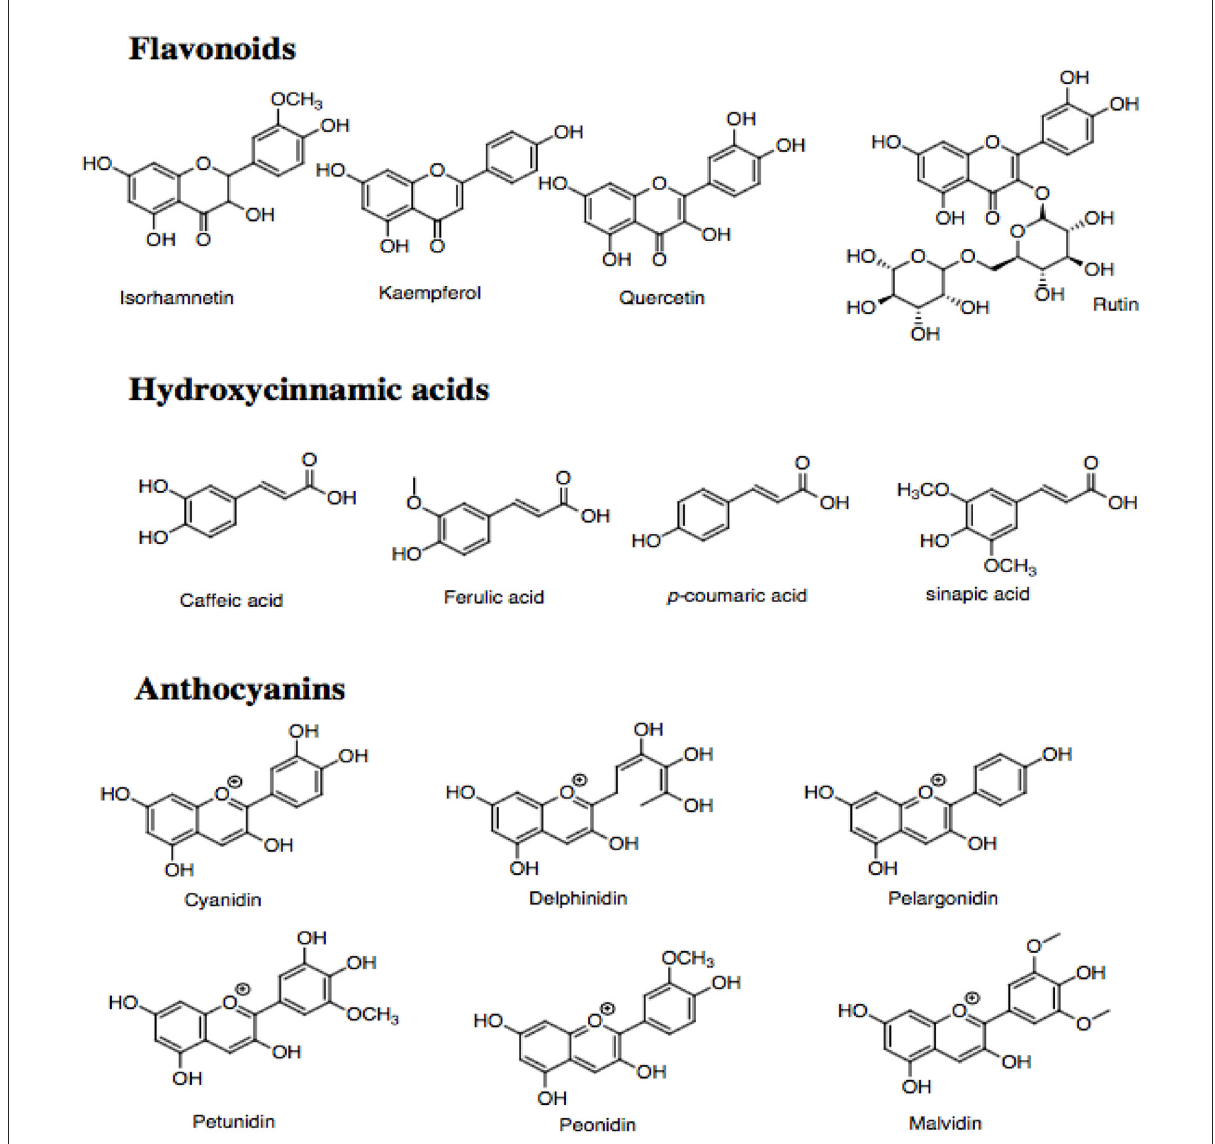
FIGURE4 Phenolic compounds present in cruciferous